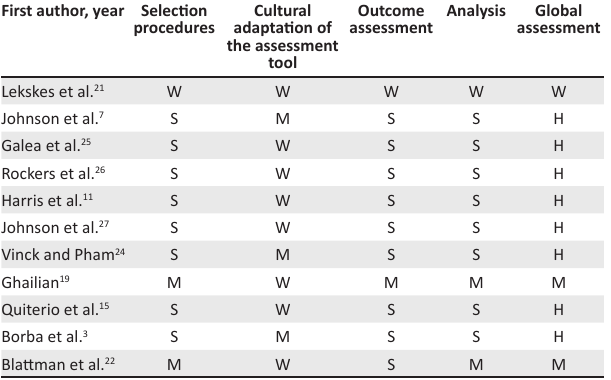
TABLE 2: Quality assessment for quantitative